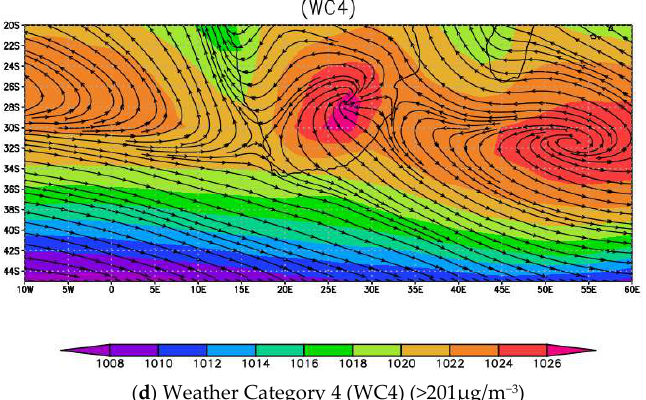
Figure 8. The classified atmospheric synoptic weather system based on PM 10 concentration categories.